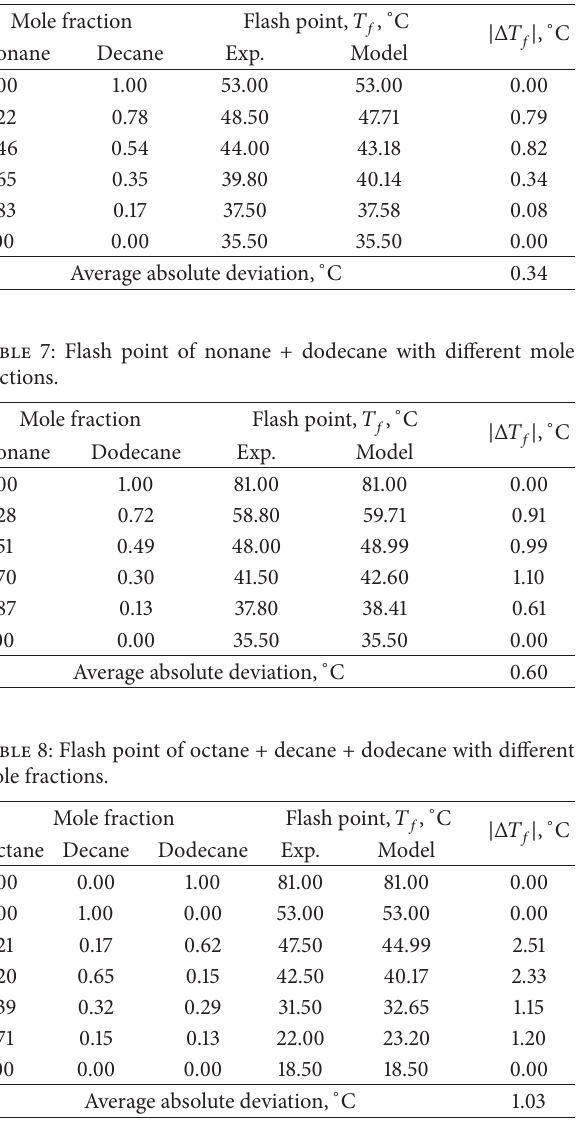
Table 6: Flash point of nonane + decane with different mole fractions.